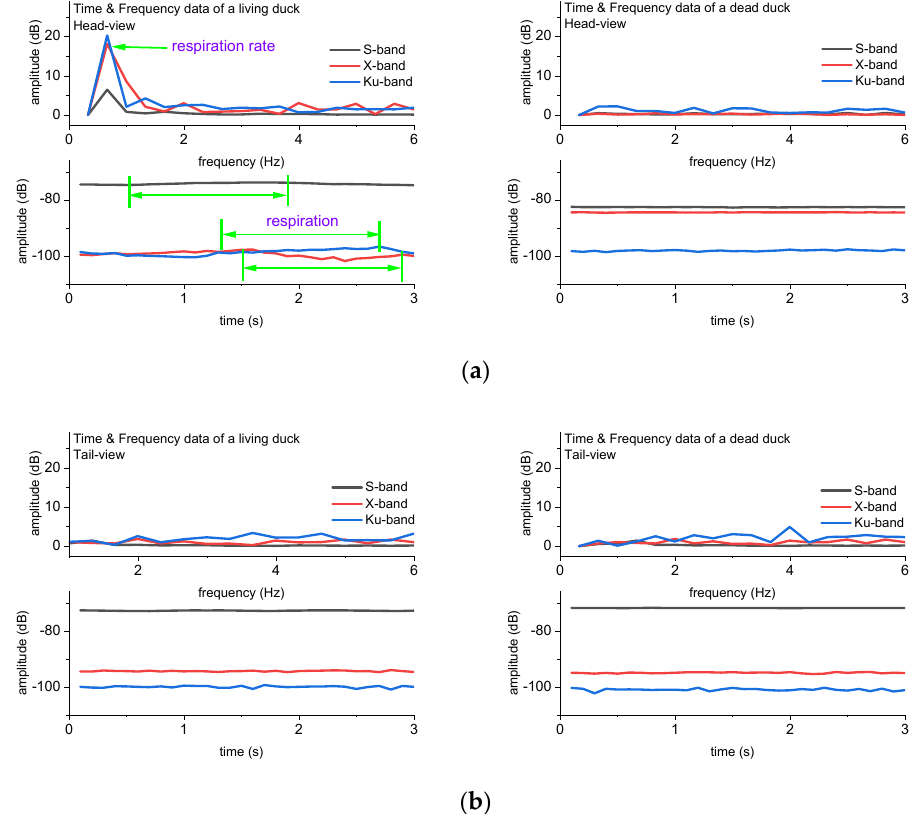
Figure 6. The comparison of signal fluctuations produced by respiration. ( a ) Radar signals in time series and spectrum of a duck (head-view, HRRP), ( b ) Radar signals in time series and spectrum of a duck (tail-view, HRRP).